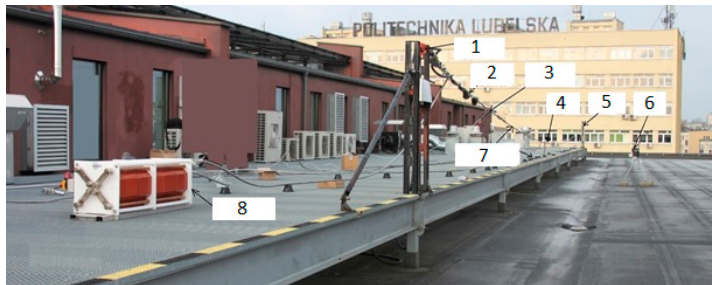
system; 3: temperature measurement; 4: sag measurement; 5: moving pole; 6: weather station; 7: ACSR Hawk conductor; 8: high-current transformer.